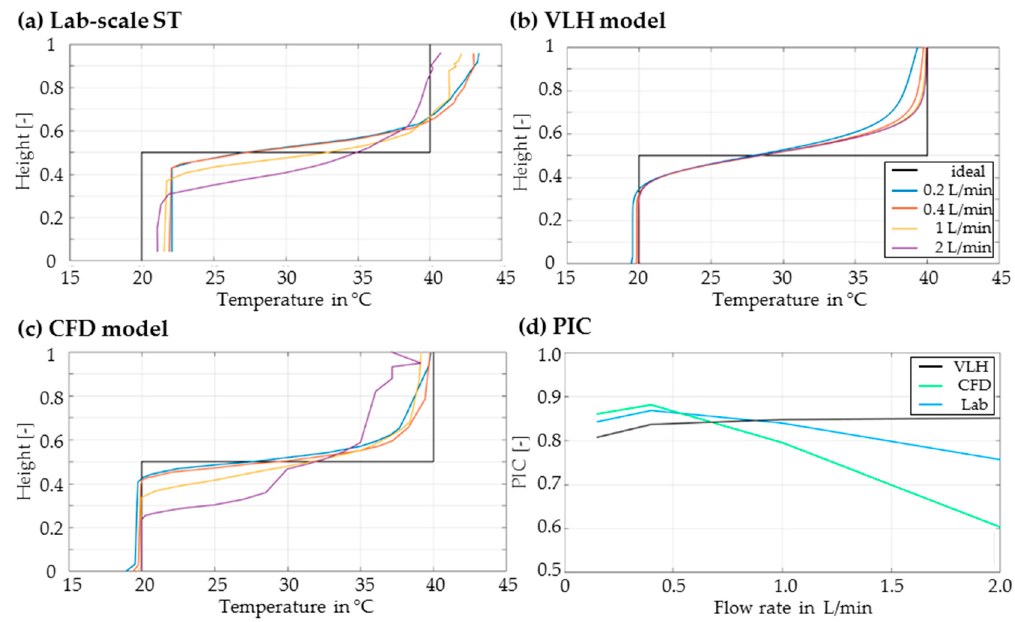
Figure 10. Influence of turbulent flows on stratification of the ( a ) lab, ( b ) VLH model and ( c ) CFD model during Charging , compared based on the ( d ) PIC value.